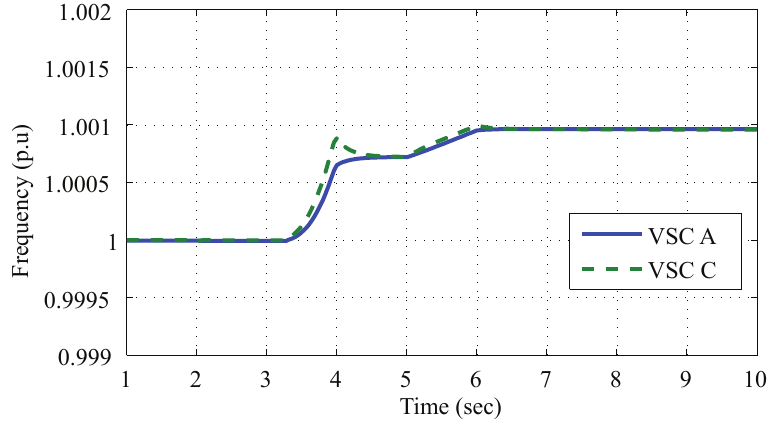
Figure 11. Frequency response of offshore side